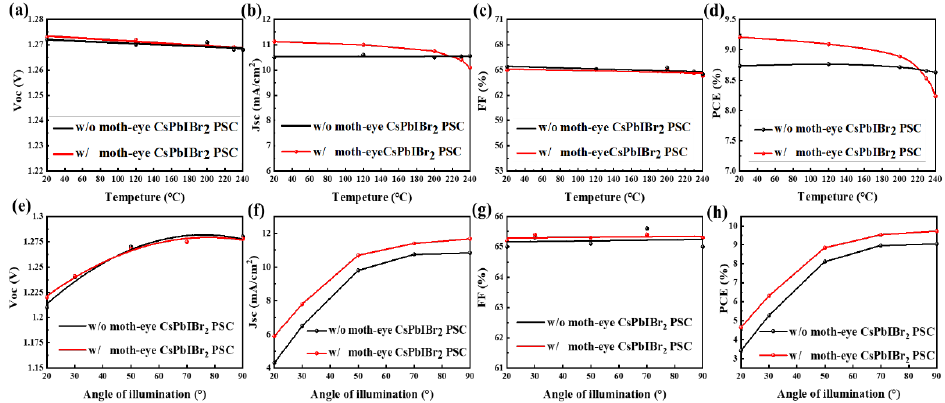
Figure 5. Characteristic curves of CsPbIBr 2 PSC with and without moth-eye nanostructures at ( a – d ) different temperatures and ( e – h ) different angles of illumination.